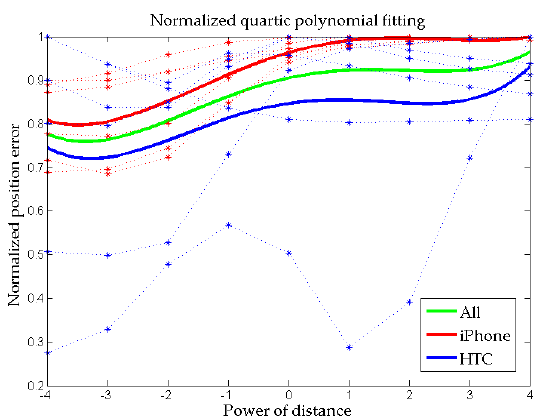
Figure 12. The fitting results of optimal weight analysis for two smartphones.